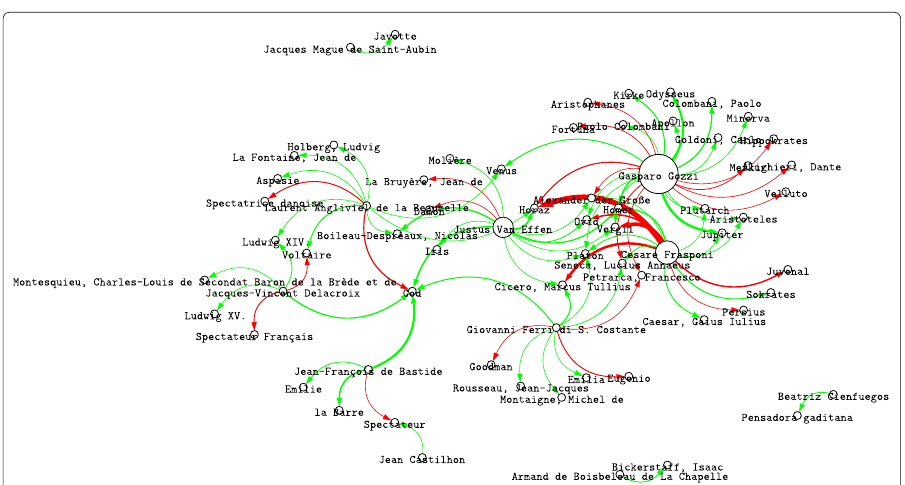
Fig. 7 Sentiment Between People. This figure depicts the authors of periodicals and the people (real and fictional) referenced by them. Directed edges indicate if an author referenced a person and the color of edges illustrates the mean standardized sentiment of the text passages in which a respective person was referenced. Node sizes represent the degree of authors and edge widths represent the multiplicity of references. Note that we only show edges with a minimum multiplicity of 10 and do not consider anonymous publications for this